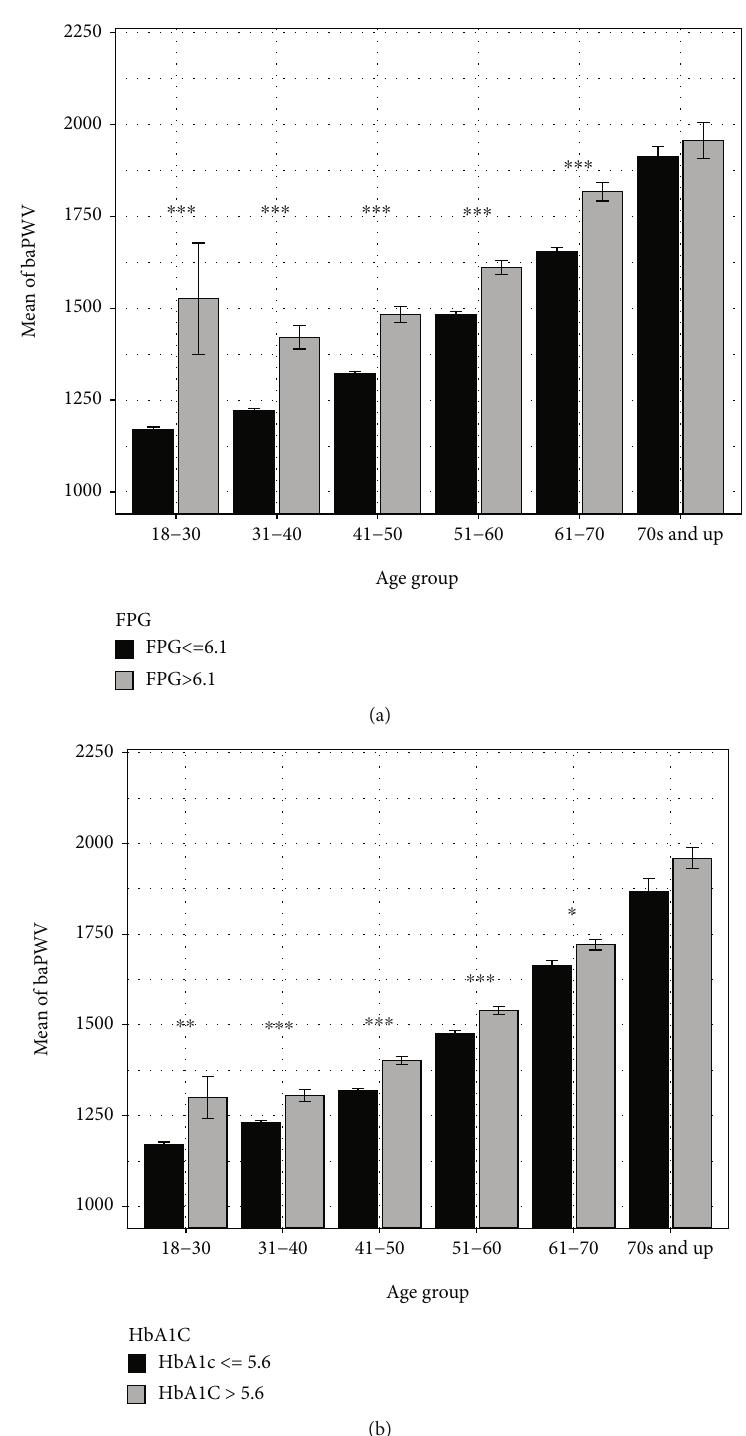
Figure 3: The temporal patterns of baPWV in cohorts with high or low fasting plasma glucose (FPG) (a) and hemoglobin A1C (HbA1c) (b). The mean baPWV for individuals with high blood glucose was signi fi cantly greater than the corresponding mean baPWV for individuals with low blood glucose with the exception of those in the “ 70s and up ” age group. Signi fi cance level: P < 0 : 001 ( ∗∗∗ ), P < 0 : 01 ( ∗∗ ), and P < 0 : 05 ( ∗